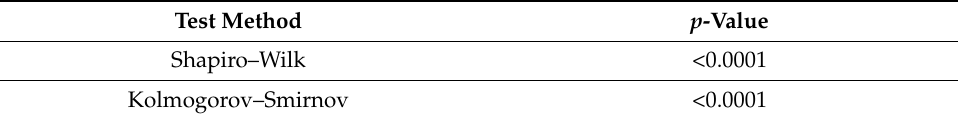
Table 6. Normality test results.